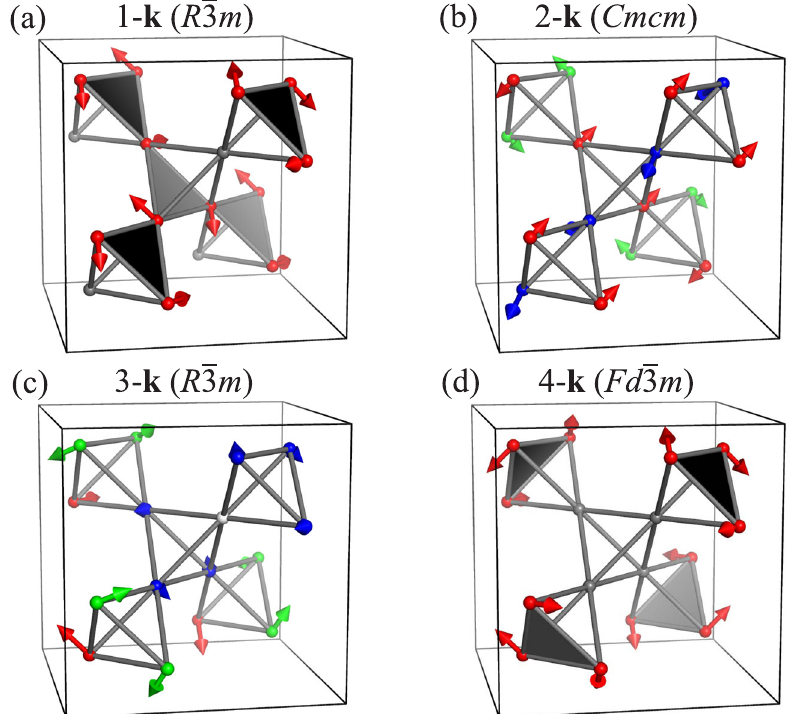
Fig. 1 Candidate magnetic structures. Basic candidate structures for Gd 2 Ti 2 O 7 , showing a 1- k , b 2- k , c 3- k , and d 4- k structures. The symmetry of each structure is labeled. A single crystallographic unit cell is shown in each case; spin orientations are reversed in adjacent unit Þ propagation vector. Spin directions are shown as arrows with lengths proportional to the ordered moment cells because of the k ¼ ð 1 21 21 2 magnitude μ ord , and the spin planes of triangular plaquettes for the 1- k and 4- k structures are shaded gray. Arrows of different colors indicate symmetry-inequivalent magnetic sites, and paramagnetic sites with zero μ ord in a , c , and d are shown as gray